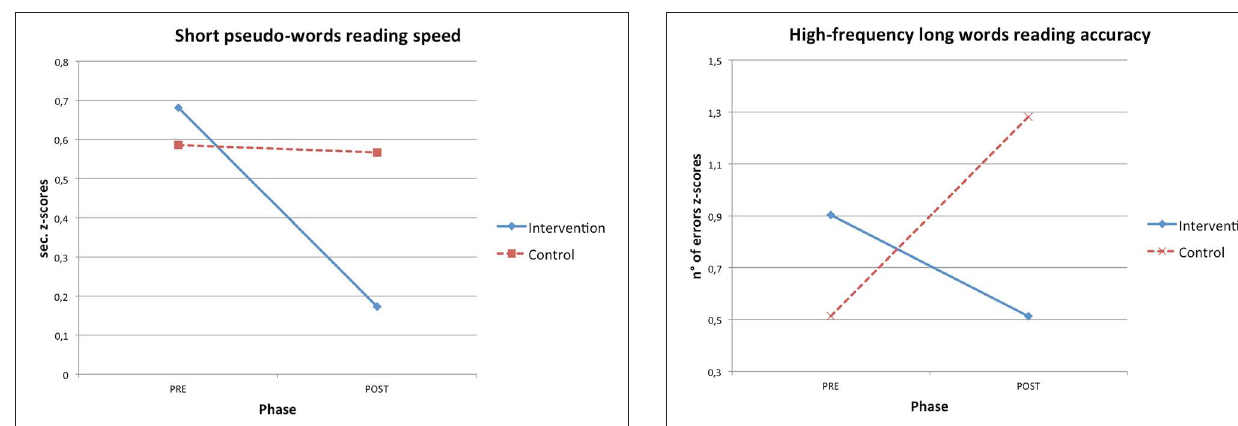
FIGURE 3 | Phase X condition interaction effect for high frequency long word reading accuracy z-scores.